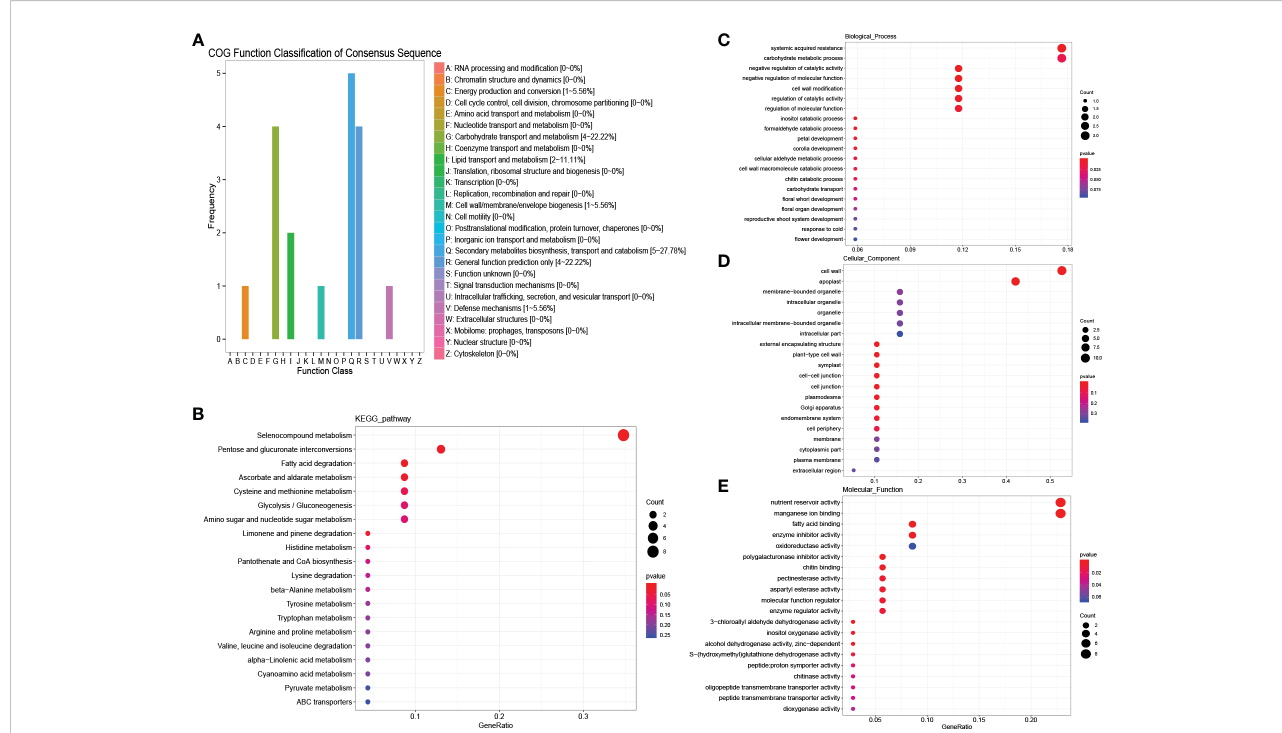
FIGURE 4 COG, KEGG and GO analysis of salinity stress responding genes in both males and females. (A) COG enrichment analysis of salinity stress responding genes in both males and females. (B) KEGG enrichment analysis of salinity stress responding genes in both males and females. (C – E) GO enrichment analysis of salinity stress responding genes in both males and